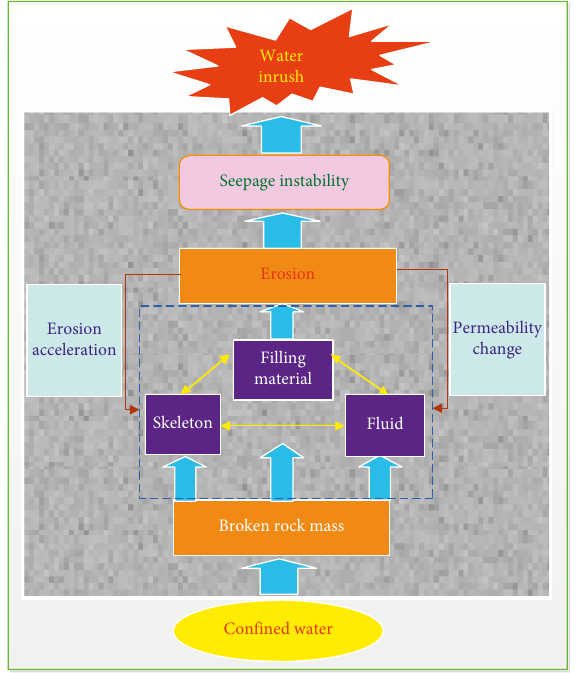
Figure 11: Schematic diagram of the seepage change process of broken rock mass seepage under the erosion effect.